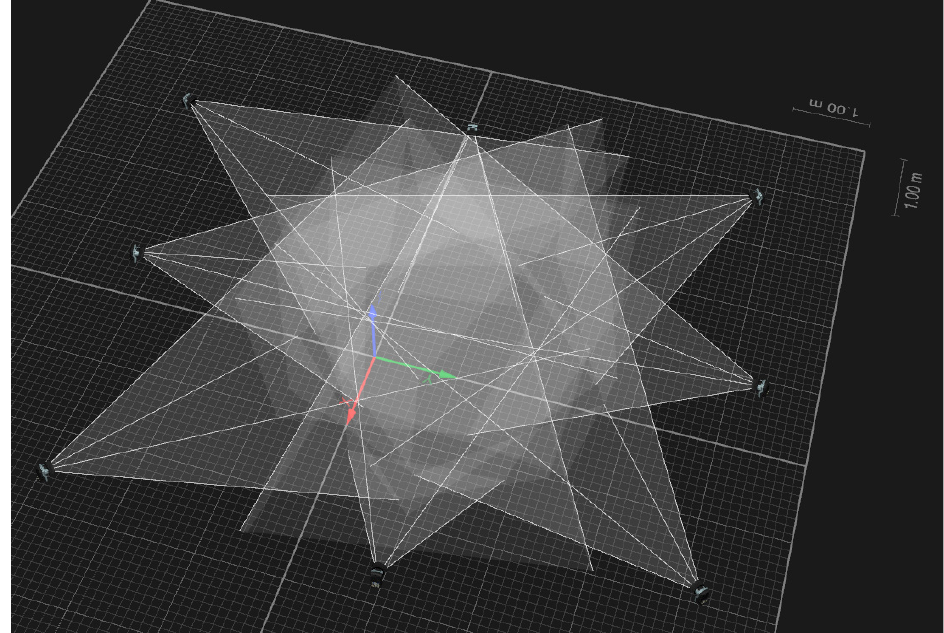
Figure 2. Three-dimensional capture area by Qualisys track manager (global coordination system, red line = x -axis, green line = y -axis, blue line = z -axis, shaded area = camera field-of-view of 3D cones).